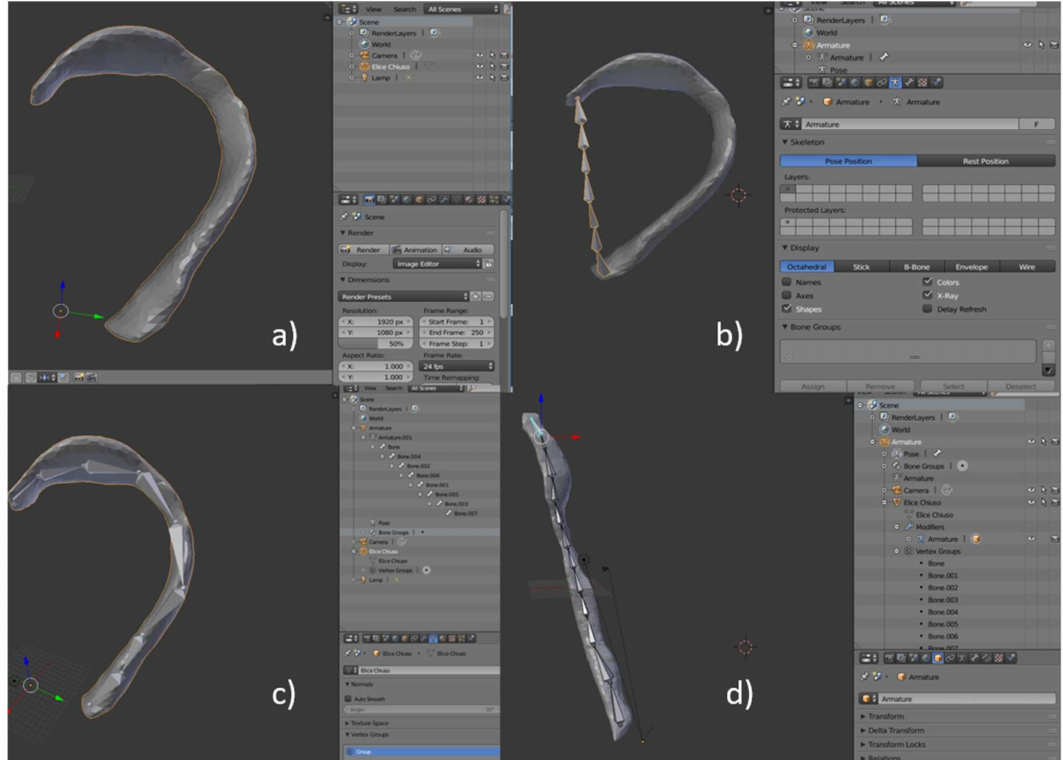
Figure 9. Process to unroll helix. ( a ) Import of the STL file in Blender; ( b ) creation of a bone chain; ( c ) placement of the bones within the helix; ( d ) digital straightening of the